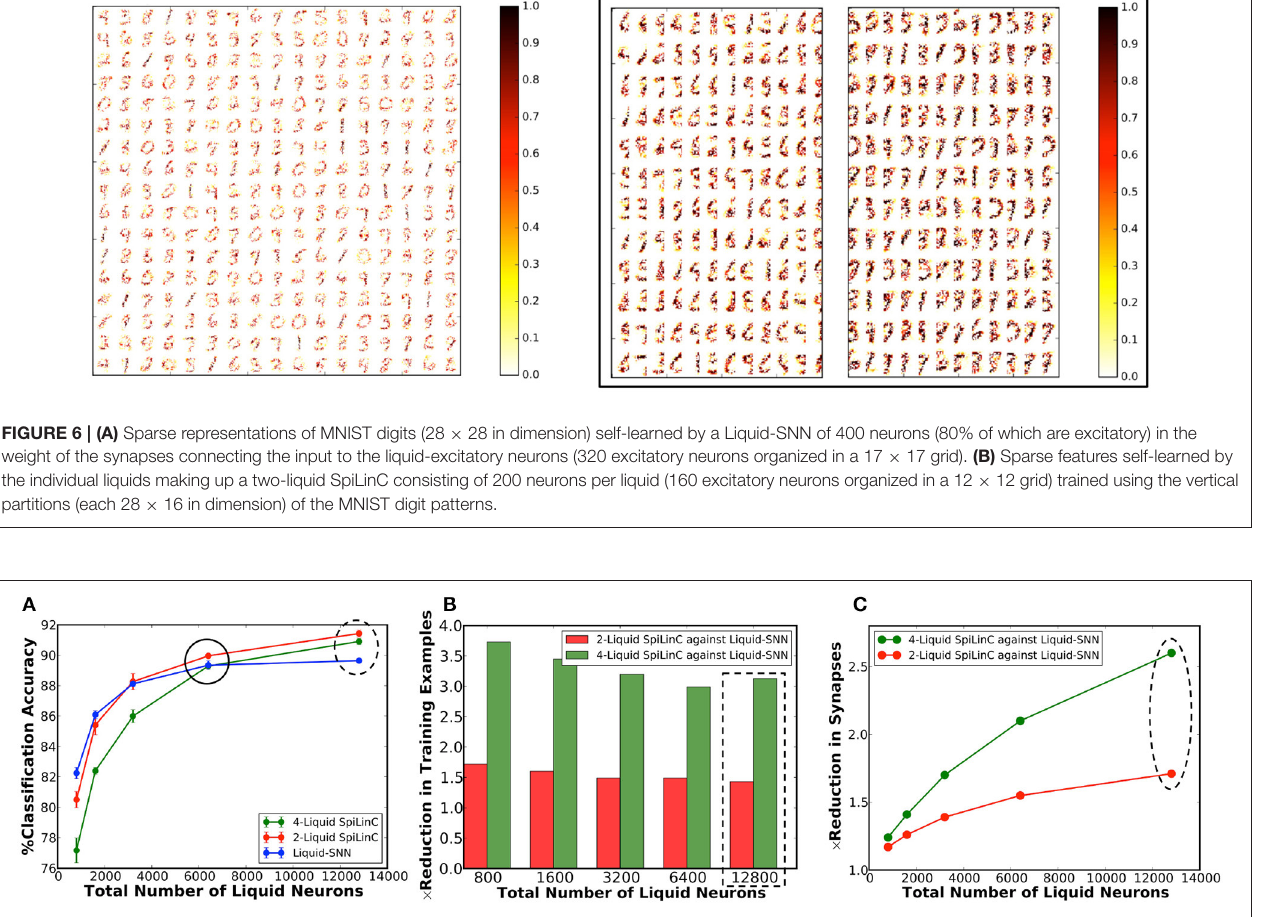
FIGURE 7 | (A) Classification accuracy of two-liquid SpiLinC, four-liquid SpiLinC, and Liquid-SNN vs. the total number of liquid neurons, evaluated on the MNIST testing dataset. (B) Reduction in the number of training examples offered by two-liquid SpiLinC and four-liquid SpiLinC over Liquid-SNN. (C) Sparsity in synaptic connectivity offered by two-liquid SpiLinC and four-liquid SpiLinC over